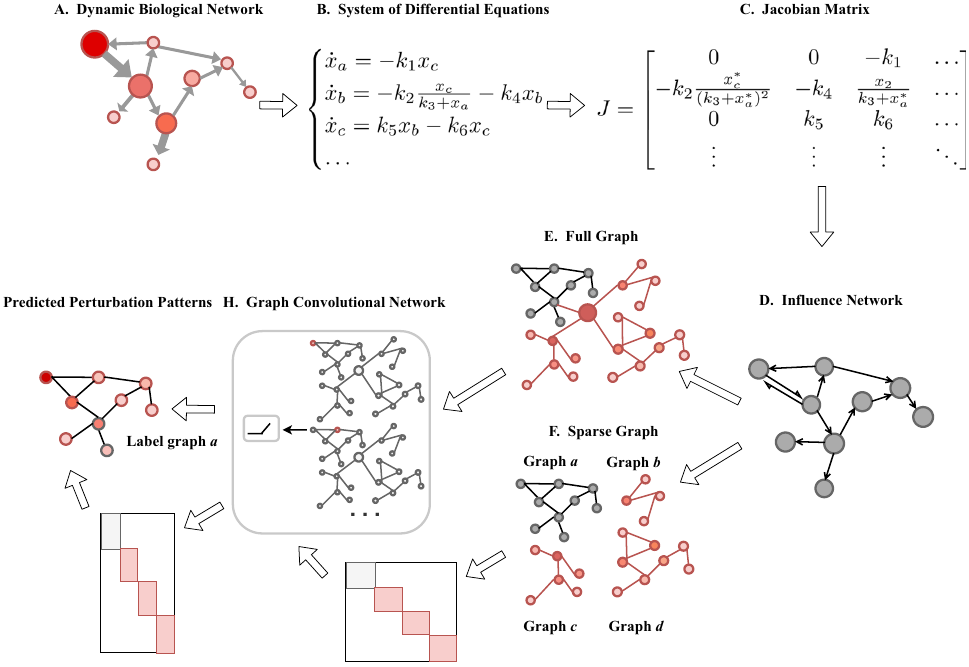
Figure 1. Flowchart of the enhancement method based on graph convolutional networks. ( A ) The topological of a directed biological network. ( B ) The dynamics of system in A can be described by a set of nonlinear differential equations. ( C ) The Jacobian matrix of the differential equations in ( B ) at its steady state. ( D ) The influence network topology can be mapped out from the Jacobian matrix in ( C ) corresponding to its adjacent matrix. ( E ) We gather all the influence networks together and generate the full graph. ( F – J ) Perturbation prediction using graph convolutional